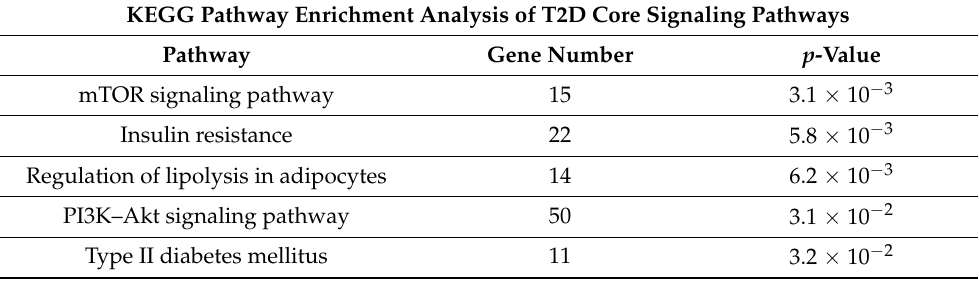
Table 3. KEGG pathway enrichment analysis of core non-T2D signaling pathways using DAVID tool. KEGG Pathway Enrichment Analysis of non-T2D Core Signaling Pathways Pathway Gene Number p -Value Jak–STAT signaling